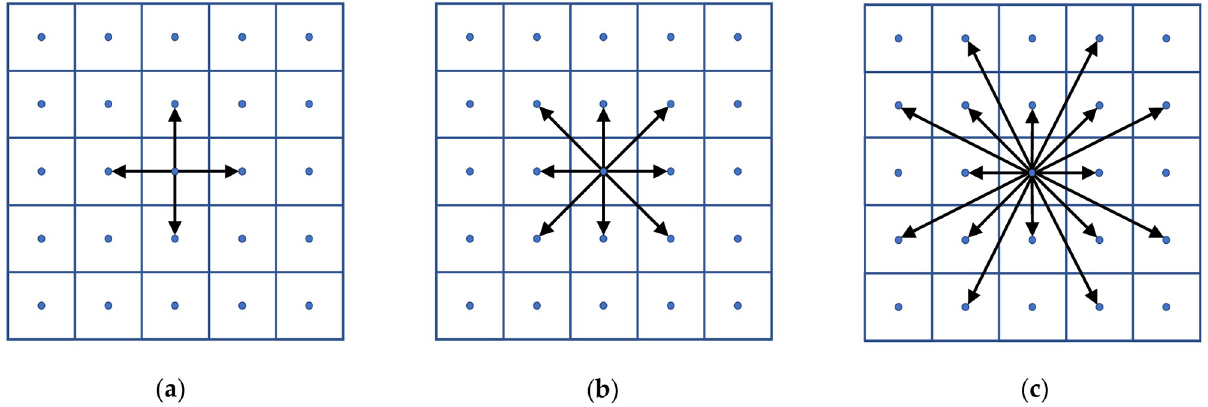
Fig 1. Raster network connectivity (a) R = 0, (b) R = 1, (c) R = 2.